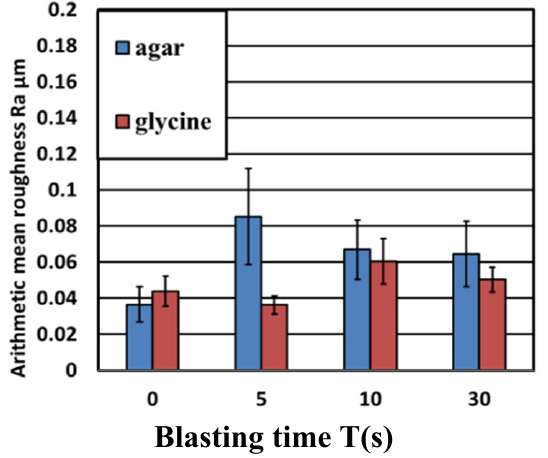
Figure 9. The changes in surface roughness are shown. The increase in surface roughness is slight and well below the target roughness Ra = 0.2 µ m, so even if agar particles and glycine particles are blasted, the effect on the surface texture of the abutment is very small.